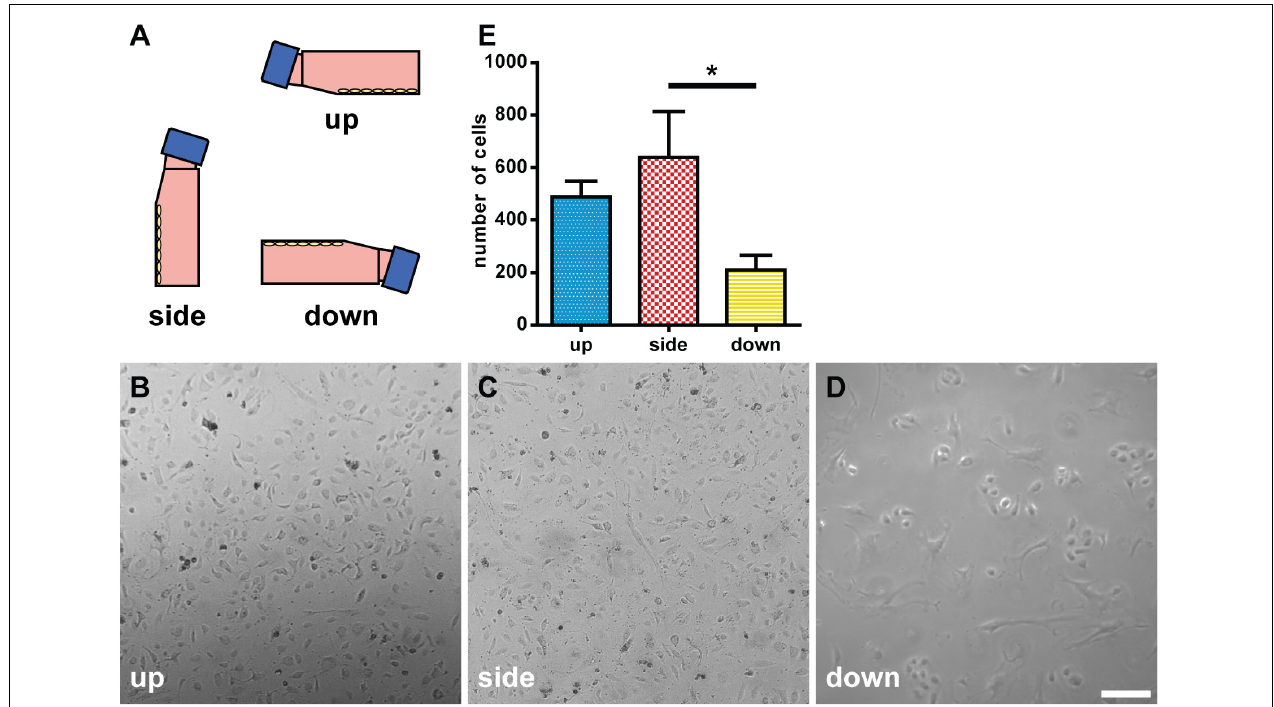
FIGURE 7 | Morphological analysis of human umbilical vein endothelial cells (HUVECs) under different gravitational configurations. (A) The gravitational configurations of cell culture. Left, up configuration; middle, side configuration; and right, down configuration. The phase-contrast images of HUVECs under the up (B) , side (C) , or down (D) configuration on day 7. Marker: 200 µ m. (E) The number of cells in the up, side, and down configurations. For each configuration n = 5. The data were expressed as the mean ± S.E.M. * p < 0.05.